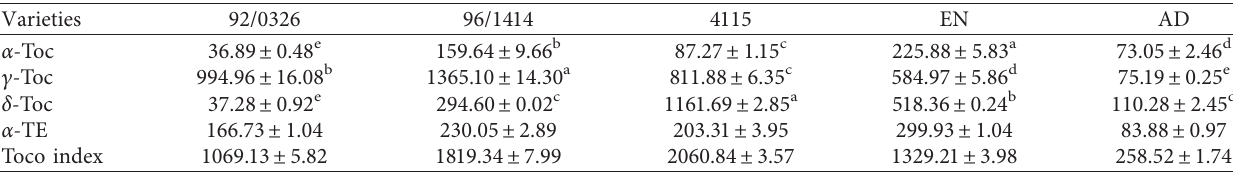
Table 3: Tocopherol isomers content of edible cassava leaf variety harvested in onset of rainy season at 12 months after planting (12MAP, 20–30 ° C, and 300–500mm).